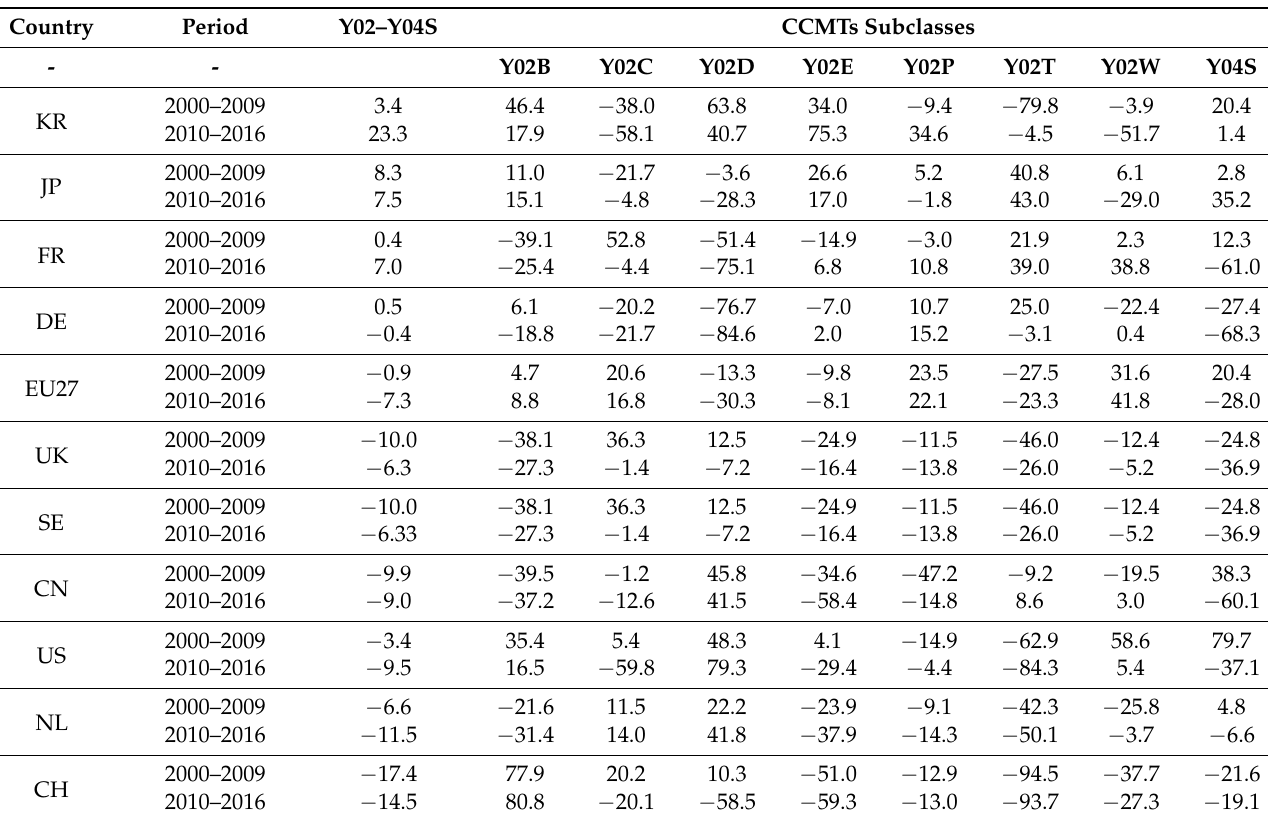
Table 3. RTA ct − Index in CCMT-TPFs; total and by CPC class (2000–2009, 2010–2016; 5-year MA), (2010–2016 top-10 patenting countries plus